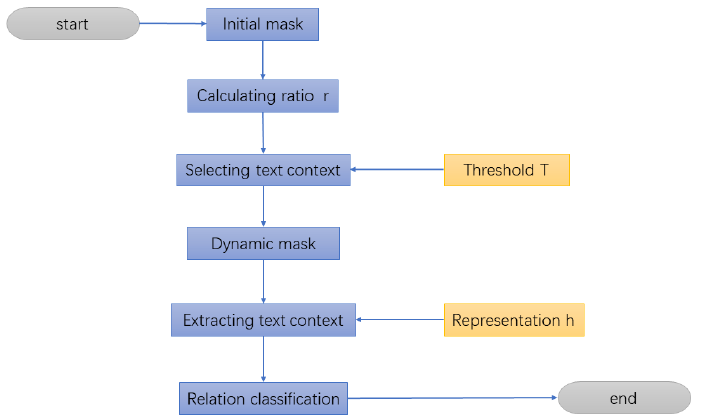
Figure 2. The flow chart of method based on threshold. This method is applied in dynamic context module for relation extraction